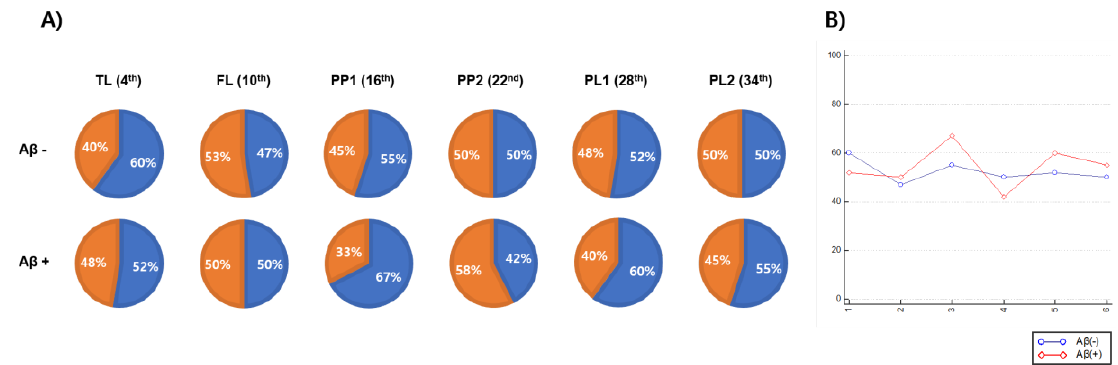
Figure 5. The results of Visual Turing test used to validate the similarity between real and generated FBB amyloid images. ( A ) Each pie chart represents the proportion of real images which an experimenter find correctly (blue) with the proportion of real images which the experiment when the real and generated images are simultaneously output to the experimenter per a representative axial level including temporal lobe (TL), frontal lobe (FL), posterior cingulate / precuneus 1 (PP1), posterior cingulate / precuneus 2 (PP2), parietal lobe 1 (PL1) and parietal lobe 2 (PL2). ( B ) A graph showing the accuracy (y-axis) with which an experimenter correctly distinguishes real images from real and generated images according to representative axial level (x-axis).